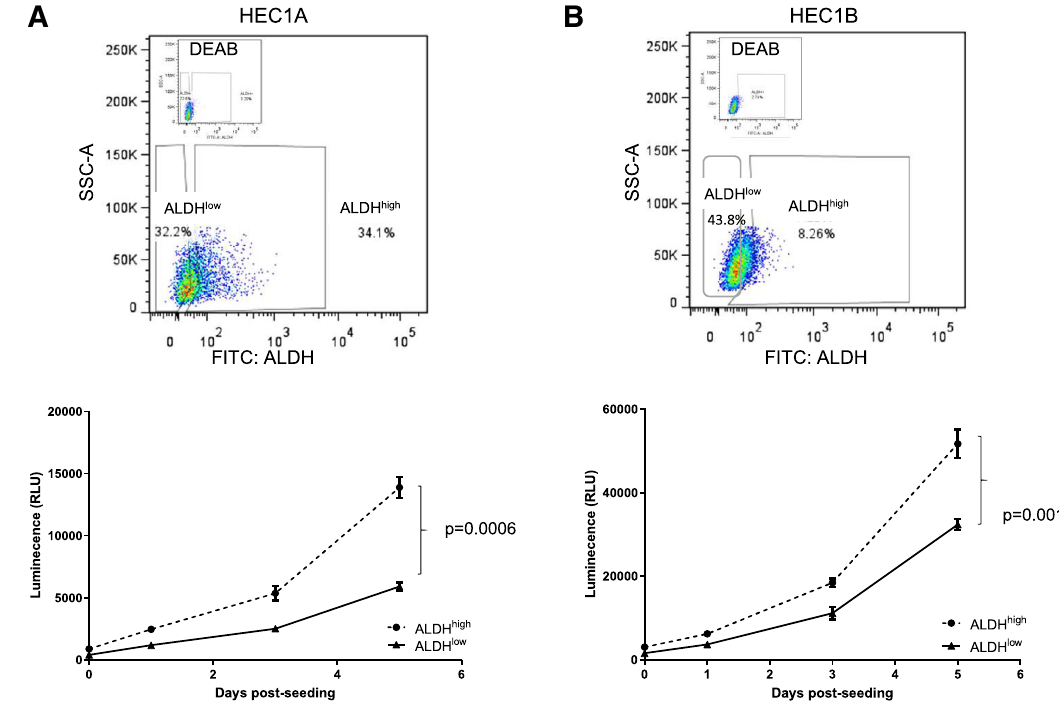
Figure 2. ALDH high cells show enhanced proliferation. ( A ) Top, Flow diagram showing the gating of ALDH high and ALDH low HEC1A cells. Bottom, The proliferation of sorted populations was evaluated over 5 days. Each sample was analyzed in triplicate with data shown as the mean ± SEM. The results shown are representative of three experiments. Two way ANOVA, p = 0.0006. ( B ) ALDH high and ALDH low HEC1B cells were sorted as above (top panel), with cellular proliferation analyzed over 5 days (bottom panel). Each sample was analyzed in triplicate with data shown as the mean ± SEM. The results shown are representative of three experiments. Two- way ANOVA, p =